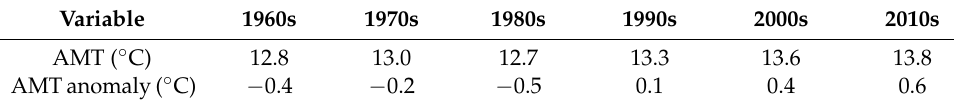
Table 1. The regionally averaged AMT in QMs for different periods. Variable 1960s